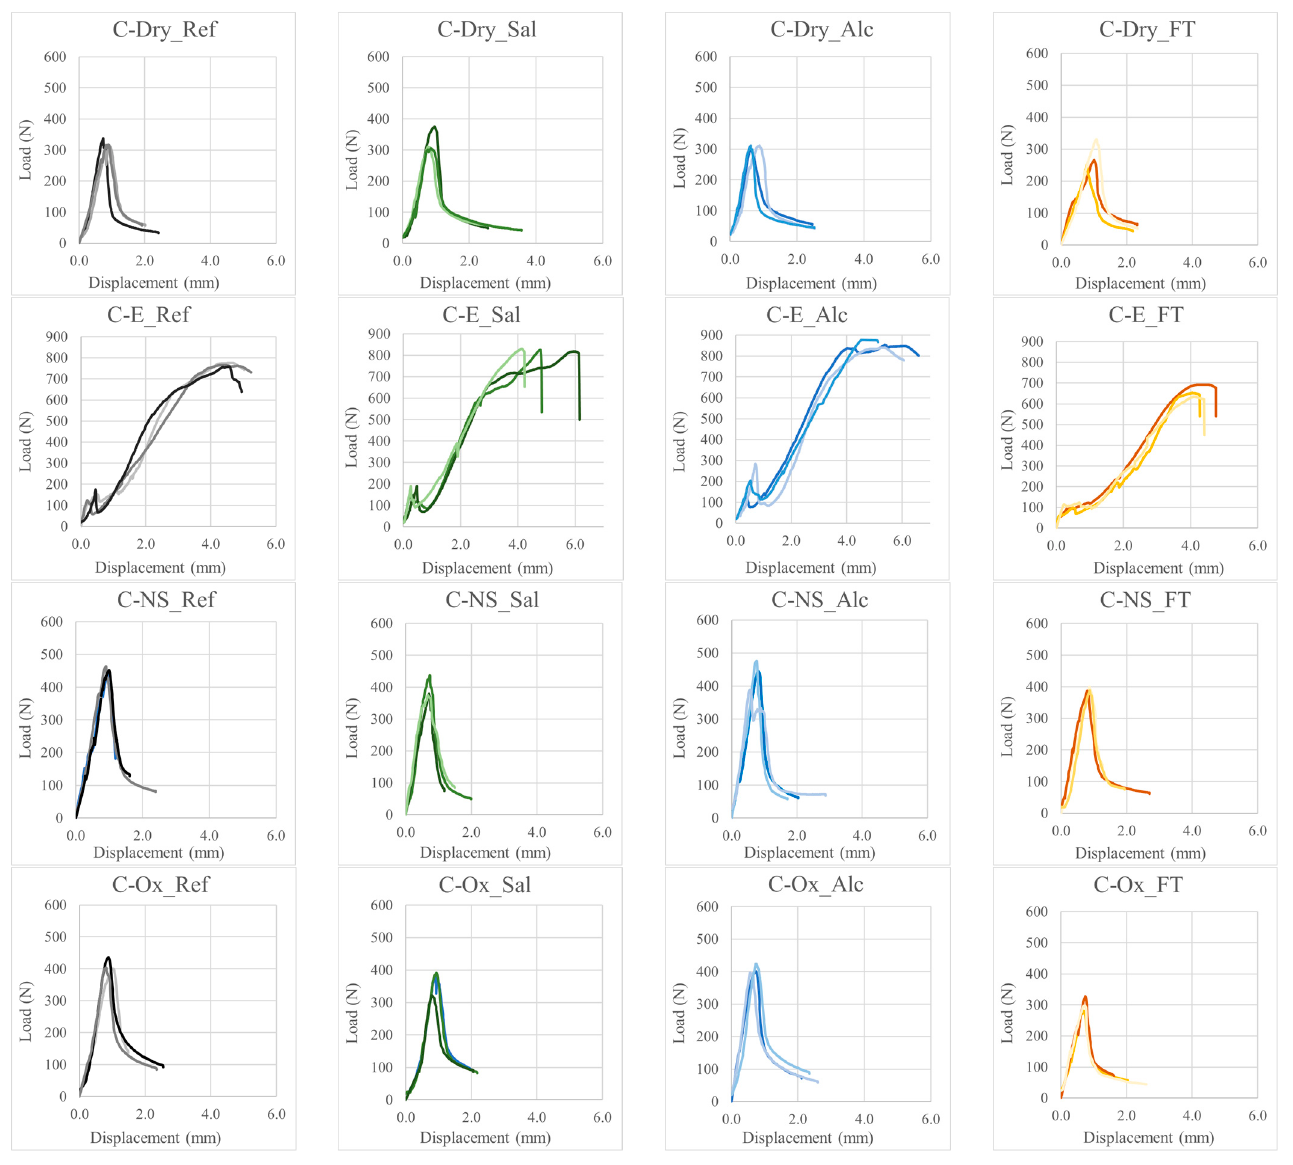
Figure 6. Load-displacement curves of pull-out tests.